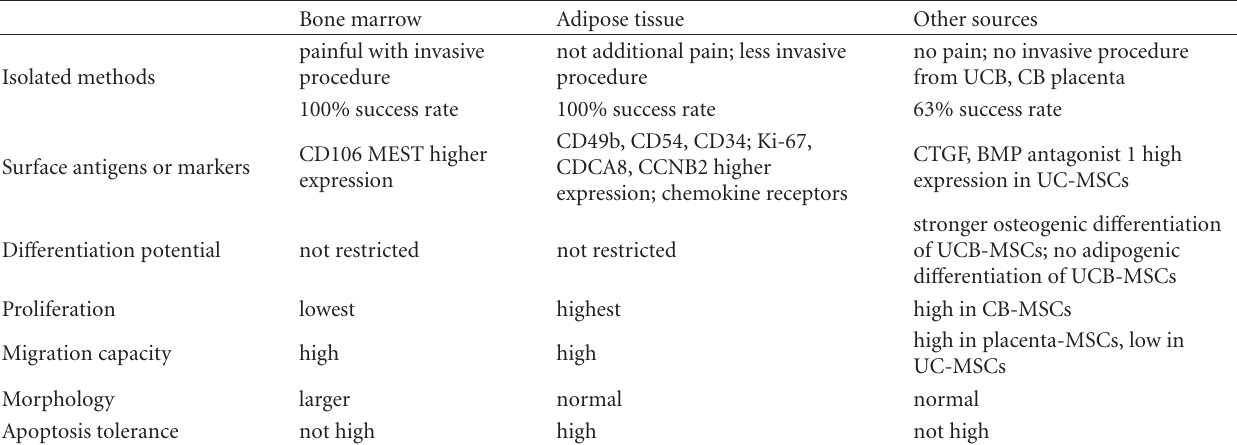
Table 1: Comparison of MSCs derived from di ff erent sources.